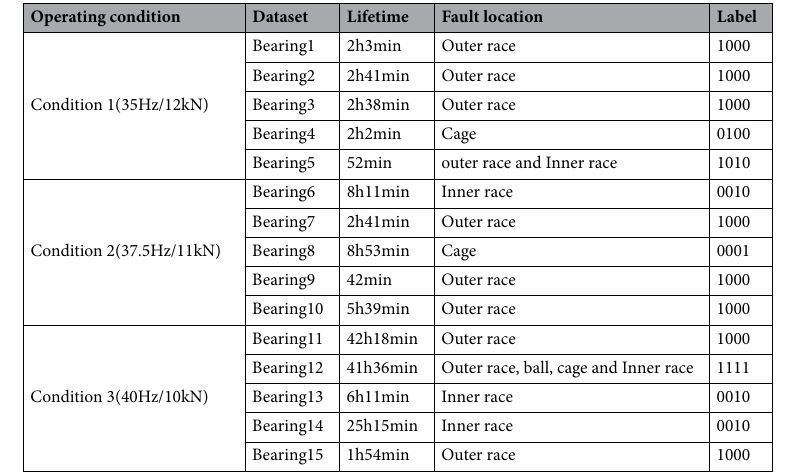
Table 4. XJTU-SY bearing dataset.